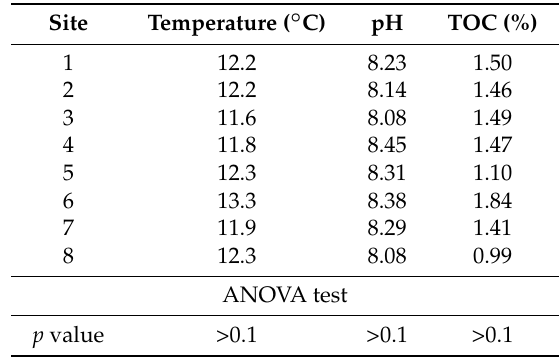
Table 1. pH, temperature and TOC values for each of the sample locations within the sub-surface coastal zone of the Dee Estuary.